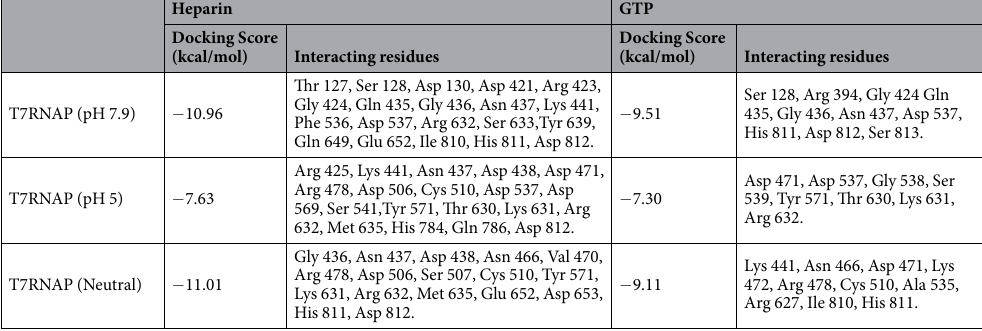
Table 1. Docking results of complexes of T7RNAP at different pH with heparin and GTP.